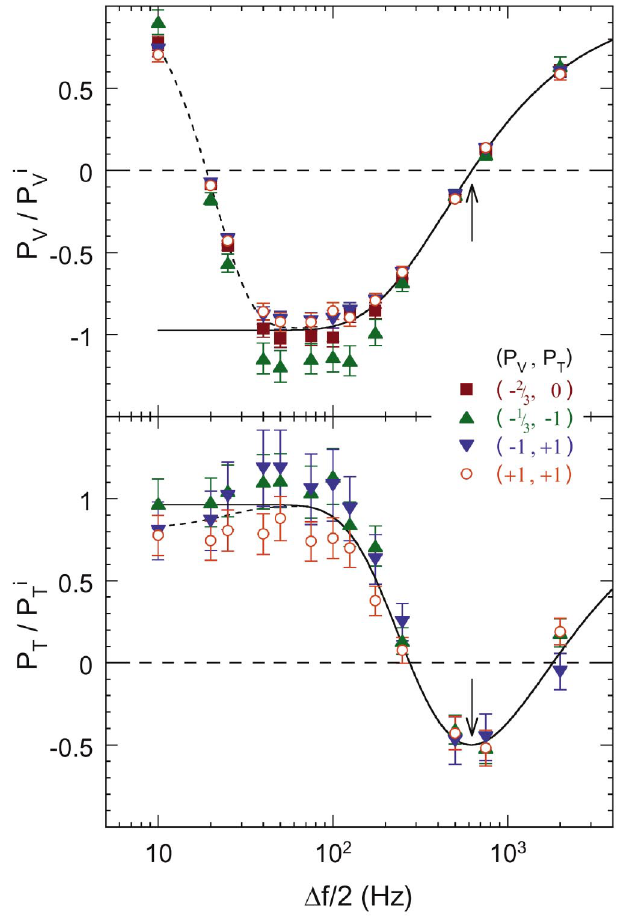
FIG. 7. (Color) The measured vector and tensor deuteron polar- ization ratios at 1850 MeV =c are plotted against the rf dipole’s and P i were obtained from frequency half-range (cid:18) f= 2 . The P i V T fits to the data as shown in Table III. The rf dipole’s ramp time dl was 0 : 54 T mm . The top and (cid:18) t was 50 s, and its R B rms bottom solid curves are fits to the data for all states at and above (cid:18) f= 2 (cid:2) 75 Hz using Eqs. (9) and (11), , respectively. The dashed lines are to guide the eye. The arrows mark a 90 (cid:11) rotation (cid:2) 0 and P (cid:2) (cid:4) 1 P i where P V T T 2